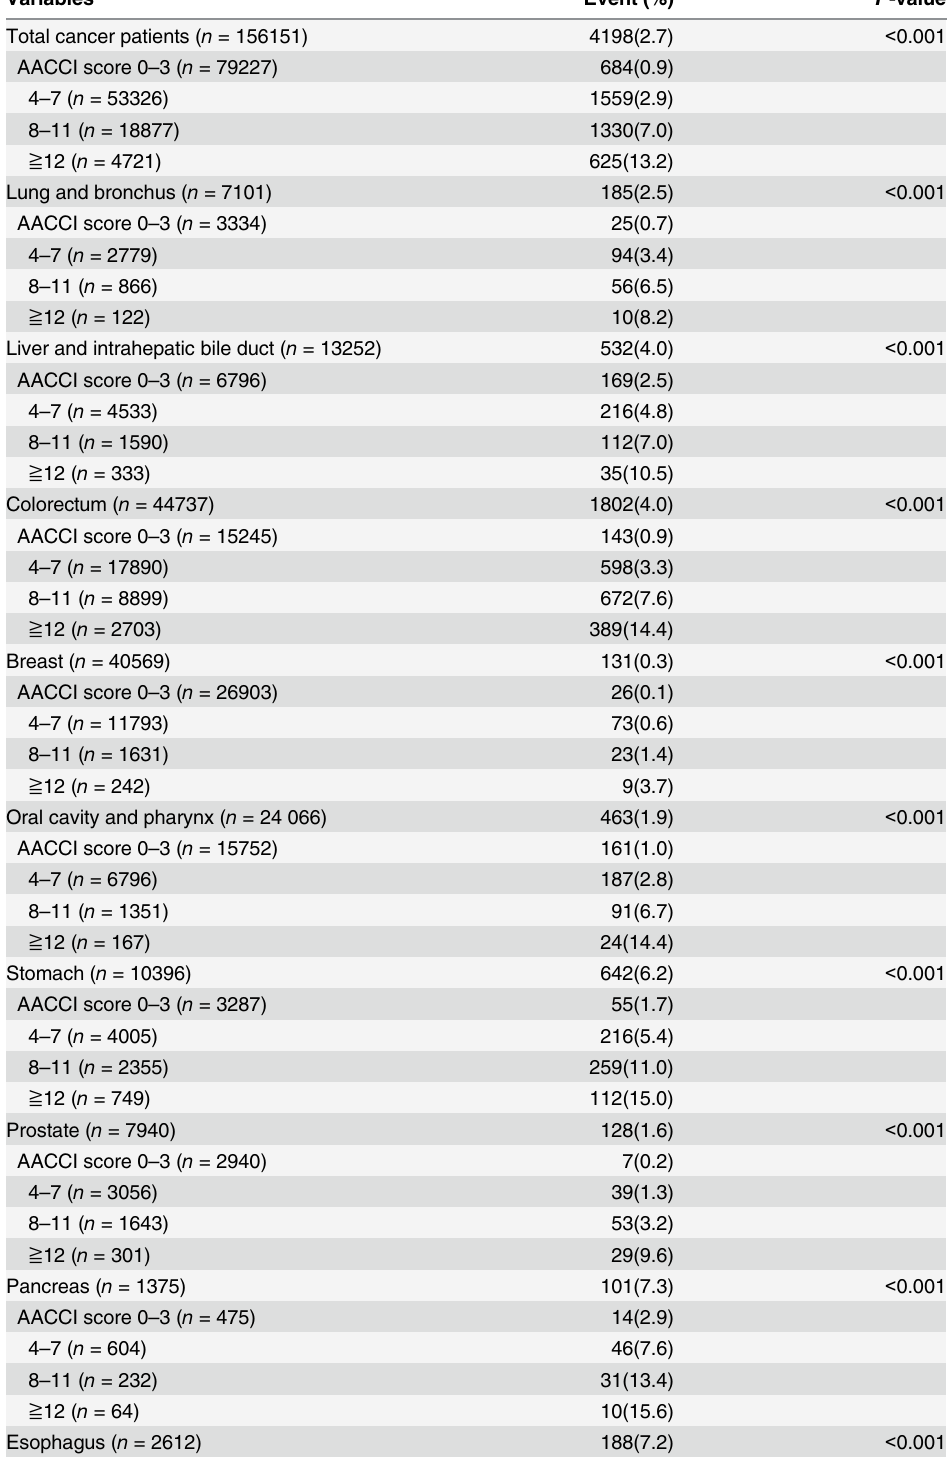
Table 5. Mortality of cancer surgery patients by cancer types and adjusted age-adjusted Charlson Comorbidity Index Score from 2007 to 2011, n =